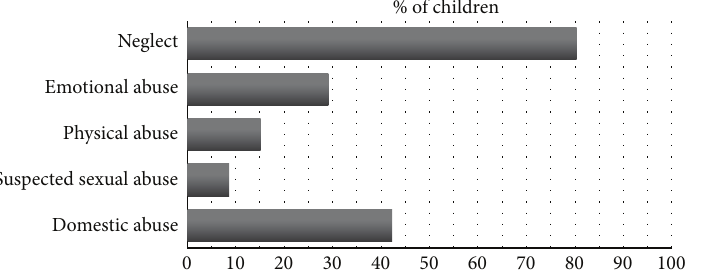
Figure 2: Type of maltreatment reported ( 𝑁 = 92 ).